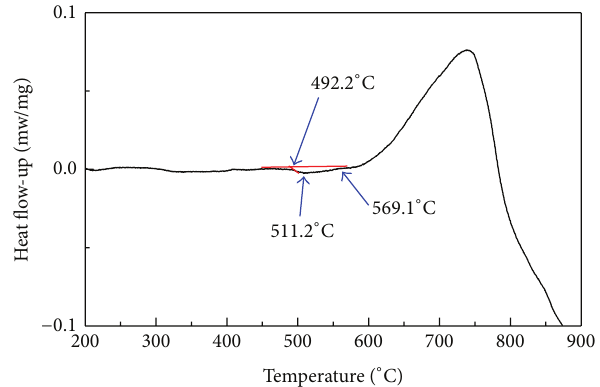
Figure 3: DSC curves of the coating after the plasma